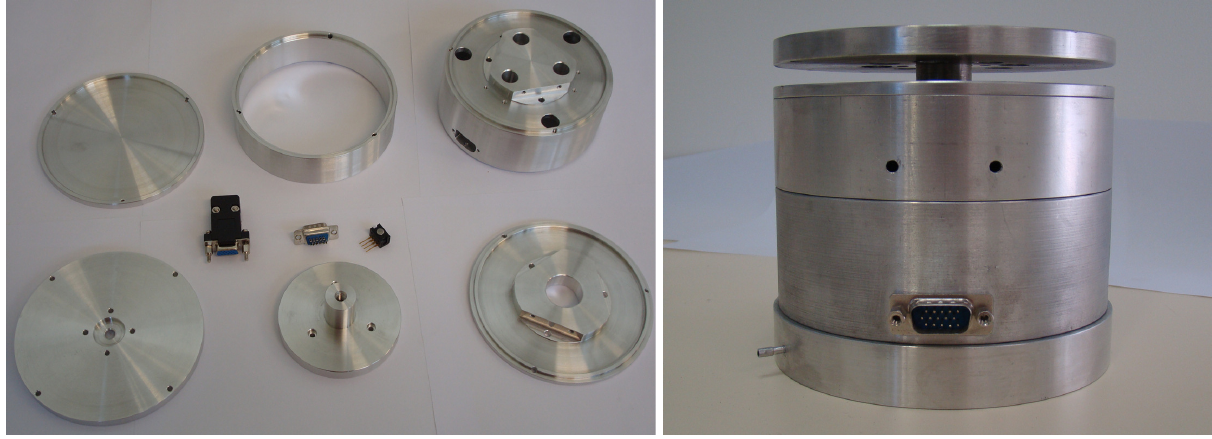
Figure 6. 3D dynamic forces/moments